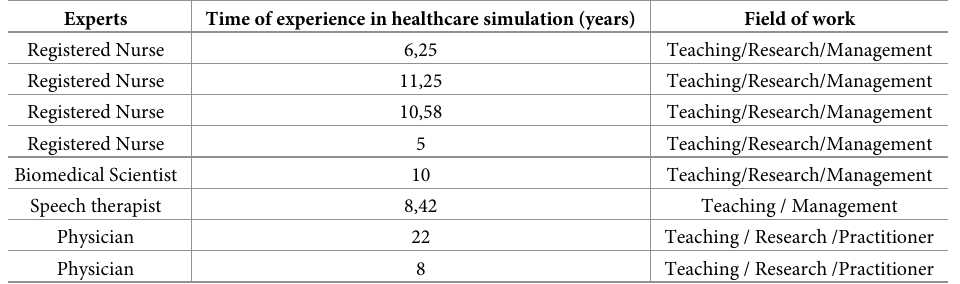
Table 1. Distribution of experts according to time of experience in healthcare simulation and field of work (n = 8), Brazil, 2018. Experts